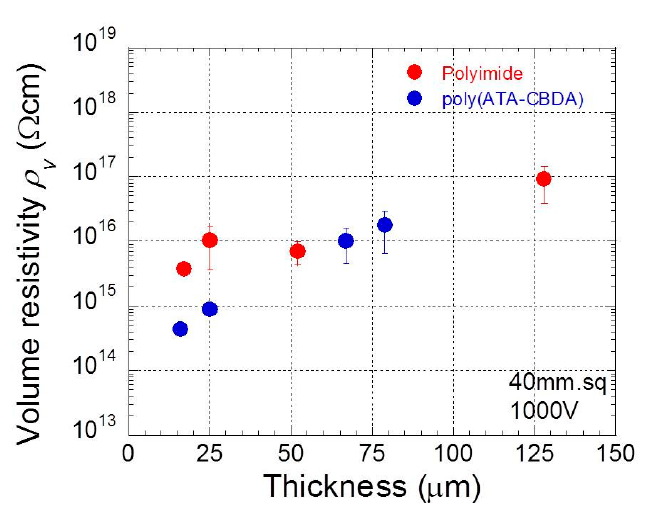
5 of 9 Figure 3. Effect of film size on electric resistivity at 1000 V for polyimide and biopolyimide films. 3.2. Thickness Dependency on Electric Resistivity Figure 4a,b demonstrate the time profiles of electric resistivity at 1000 V for polyimide and biopolyimide films with various thicknesses, respectively. The sample is a square 40 mm in size. The electric resistivity for all films increased over time during the 40 s after the electric voltage was applied. Similar phenomenon, i.e., charge current and leak current, were also observed in this experiment. It was clearly observed, for both films, that the electric resistivity depends on the film thickness. This strongly indicates that electric resistivity is a function of the electric field strength. Figure 4. Time profiles of electric resistivity at 1000 V for ( a ) polyimide and ( b ) biopolyimide films with various thicknesses. Figure 5 indicates the relationship between the averaged resistivity during 60–90 s in Figure 4 and the thickness. The electric resistivity was also averaged over three data sets measured by the same